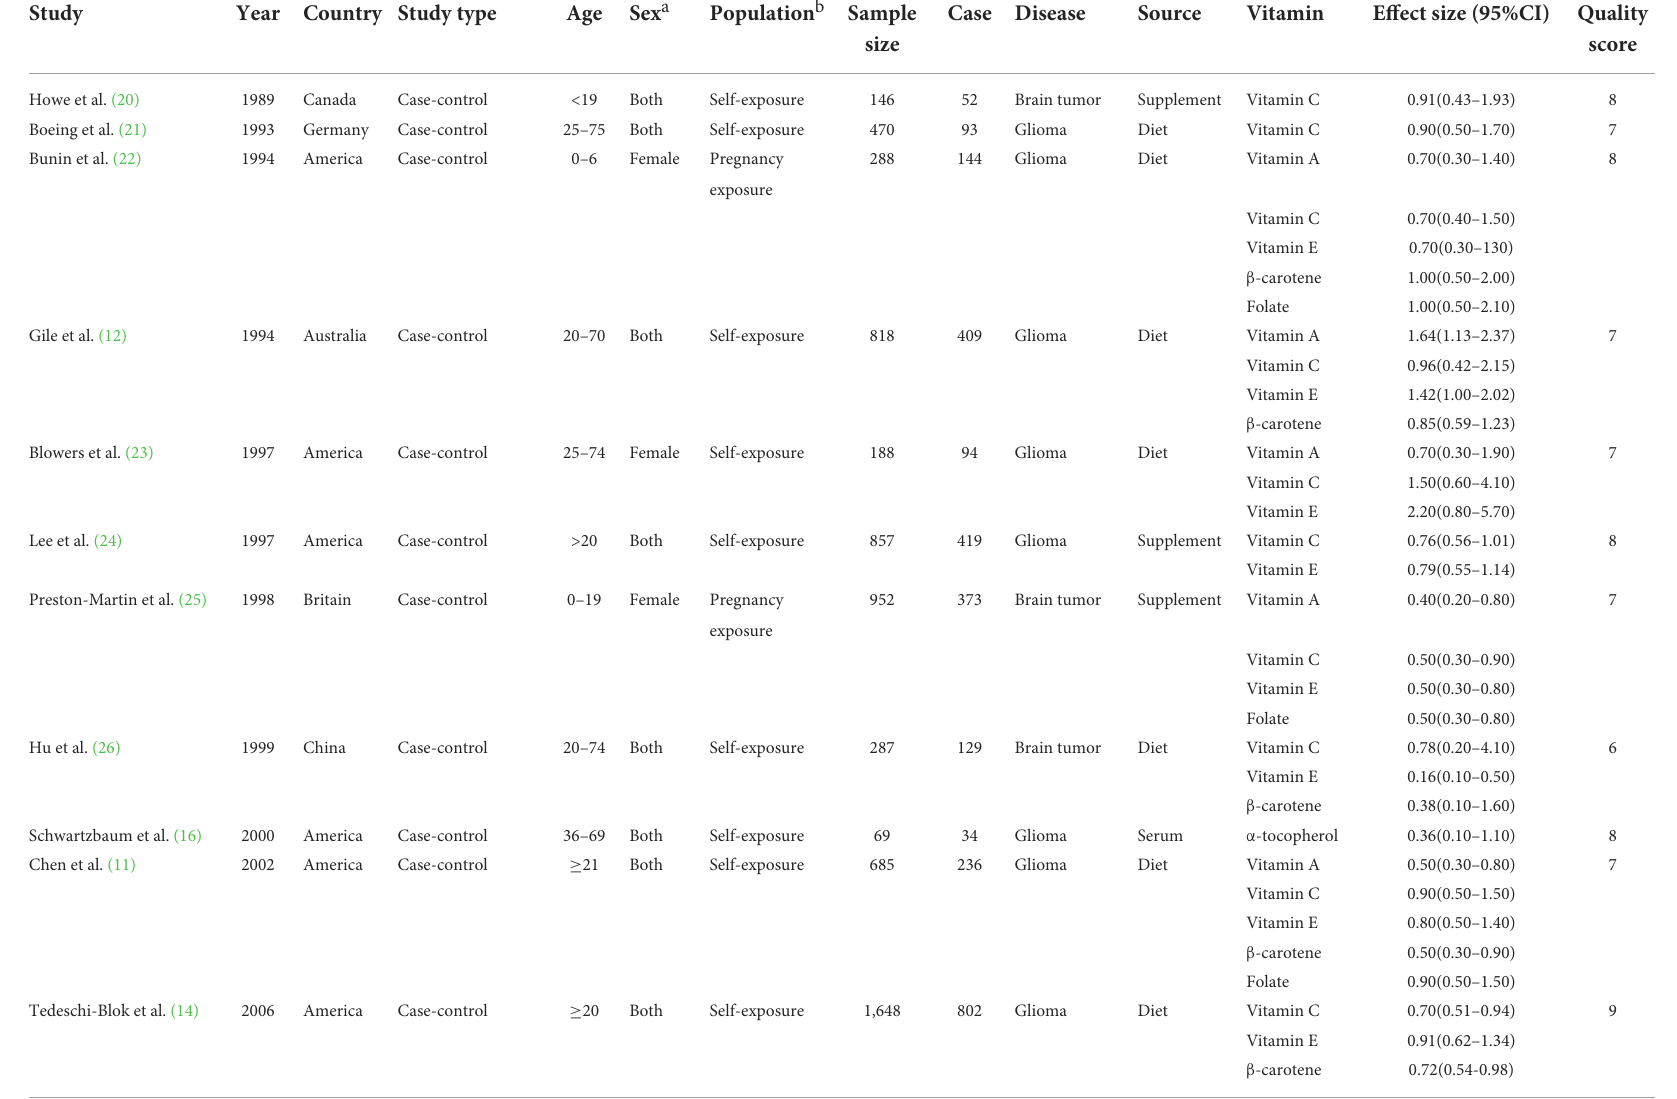
TABLE 1 Characteristics of studies investigating the association between vitamins and brain